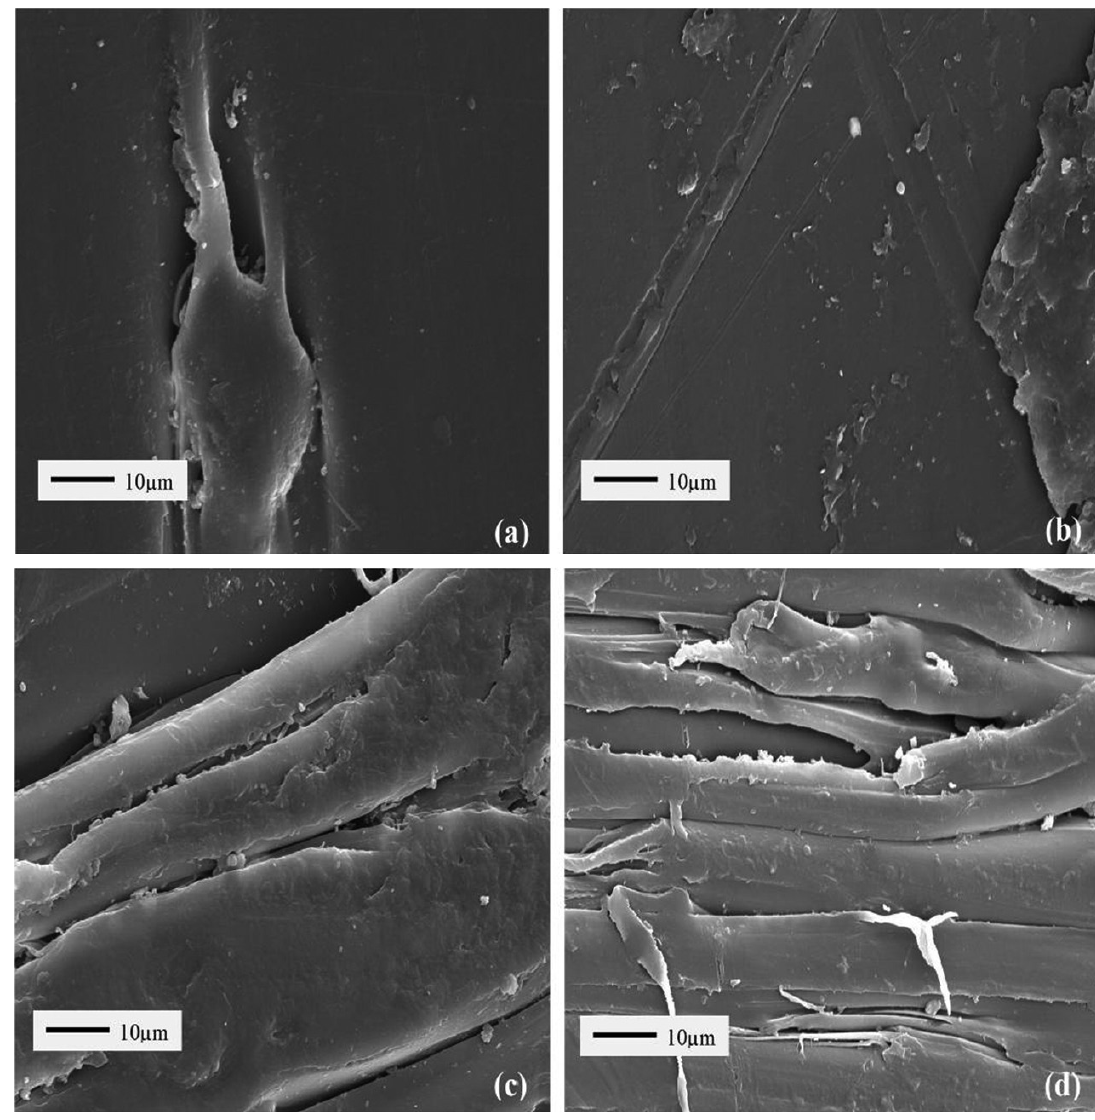
Figure 2. SEM micrograph of the sample surface after 90 days of exposure in the simulated soil: (a) rEPS, (b) rEPS/2AA, (c) rEPS/20CF and (d)